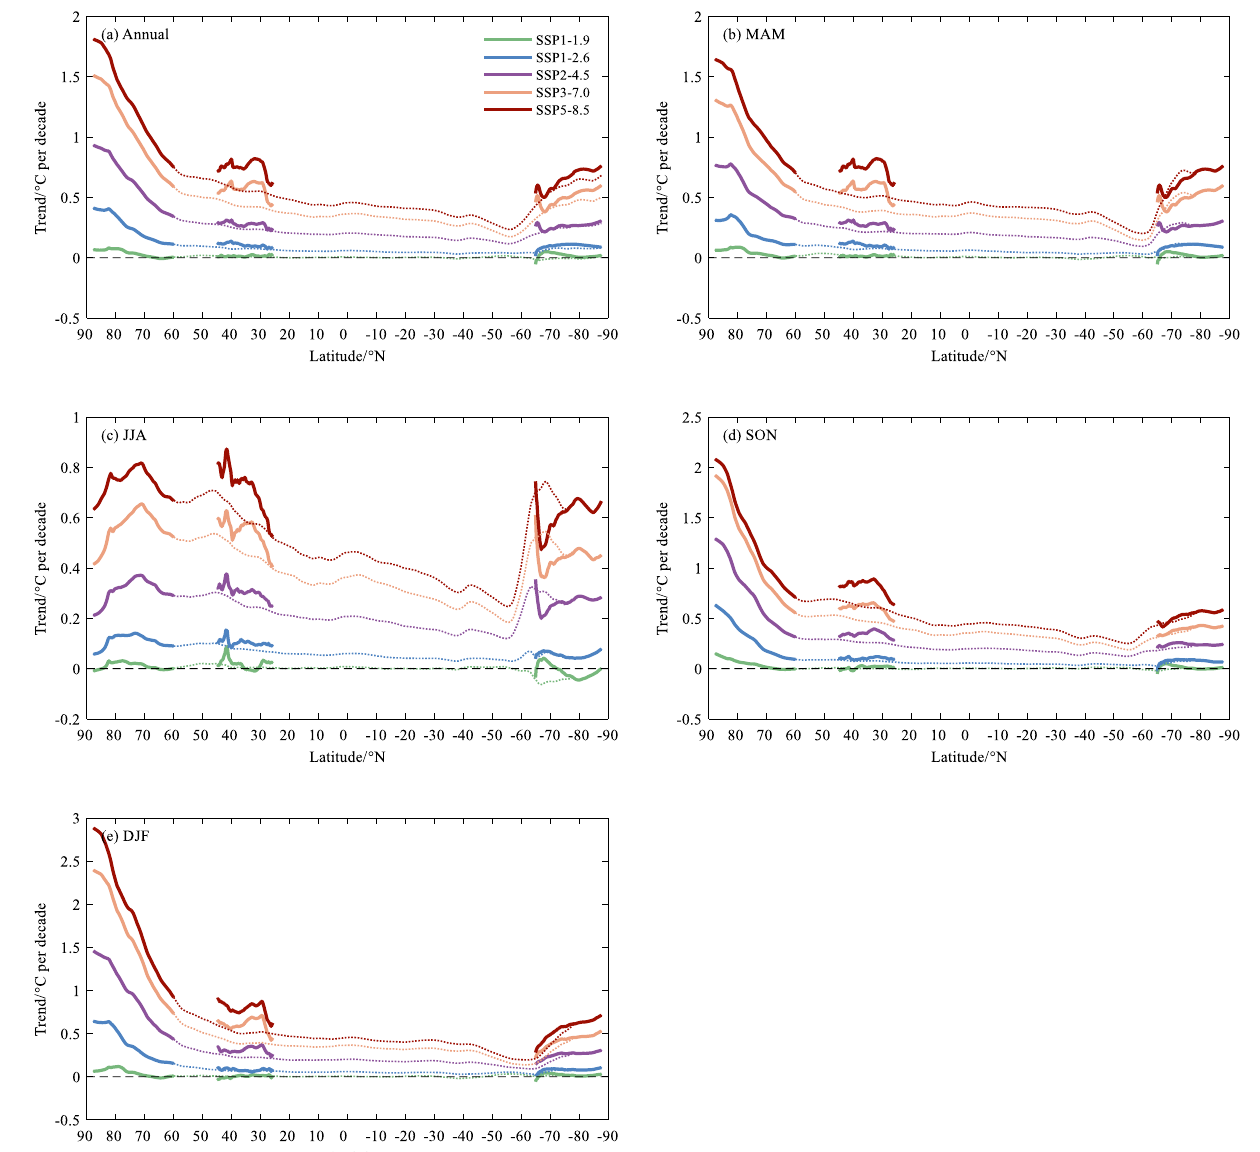
Figure 8. Zonally average temperature trends (°C per decade) for ( a ) annual and ( b–e ) seasonal during 2015– 2100 from the CMIP6 simulations MMEM under the SSPs of SSP1-1.9, SSP1-2.6, SSP2-4.5, SSP3-7.0, SSP5-8.5, respectively. The dotted line is for the zonal average from latitude circles, and the solid is for the three